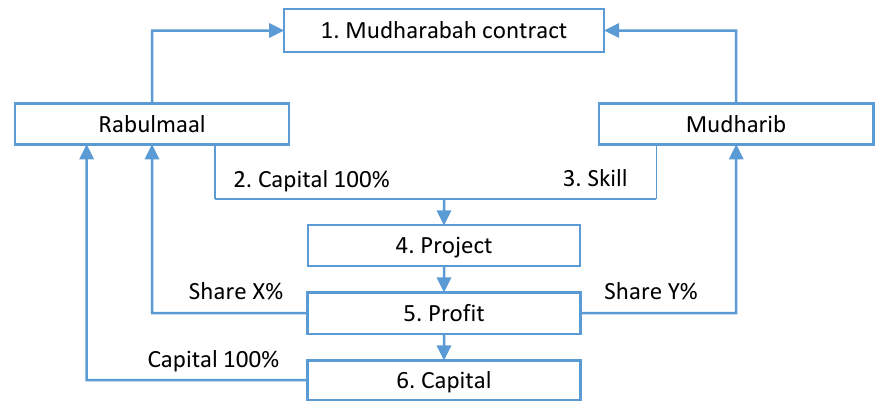
Figure 1. Mudharabah financing